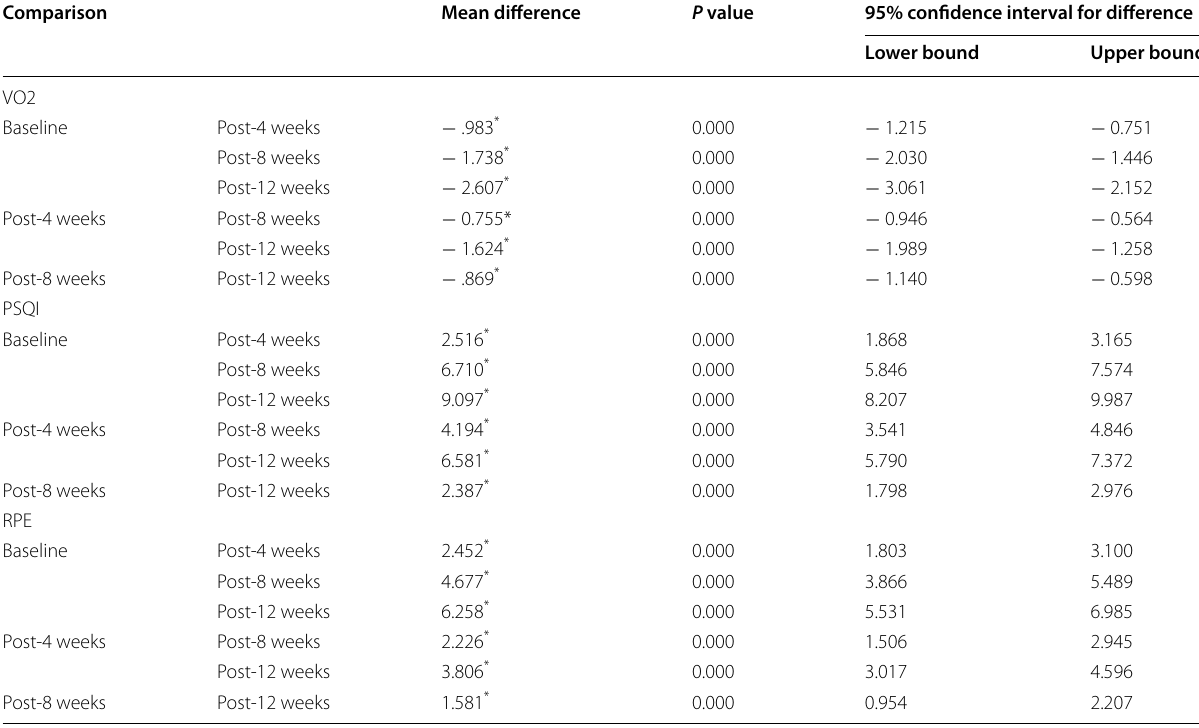
Table 3 Pairwise multiple comparison for VO2, PSQI, and RPE for the baseline to post-4 weeks, post-8 weeks, and post-12 weeks